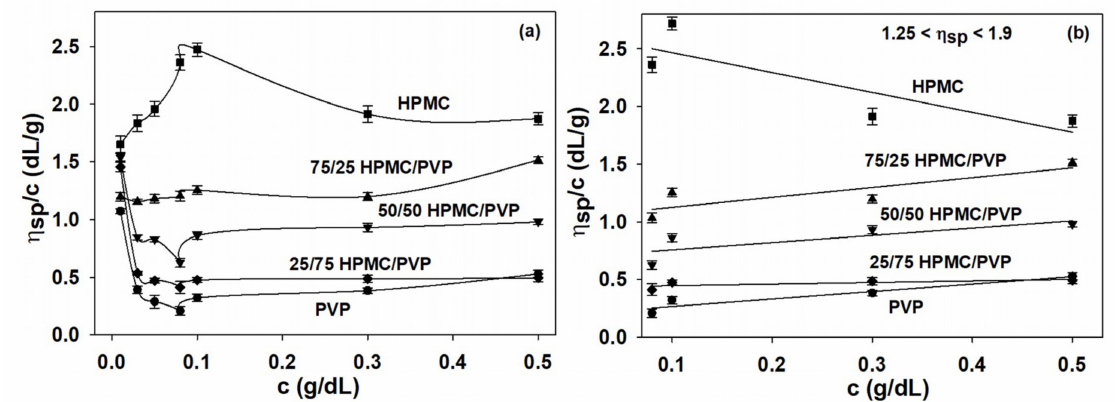
Figure 2. Huggins plots for HPMC, PVP, and HPMC/PVP mixture in water at different mixing ratios and 25 ◦ C: ( a ) over extremely dilute/dilute concentration domain and ( b ) over the dilute domain, where condition 1.25 < η rel < 1.9 was